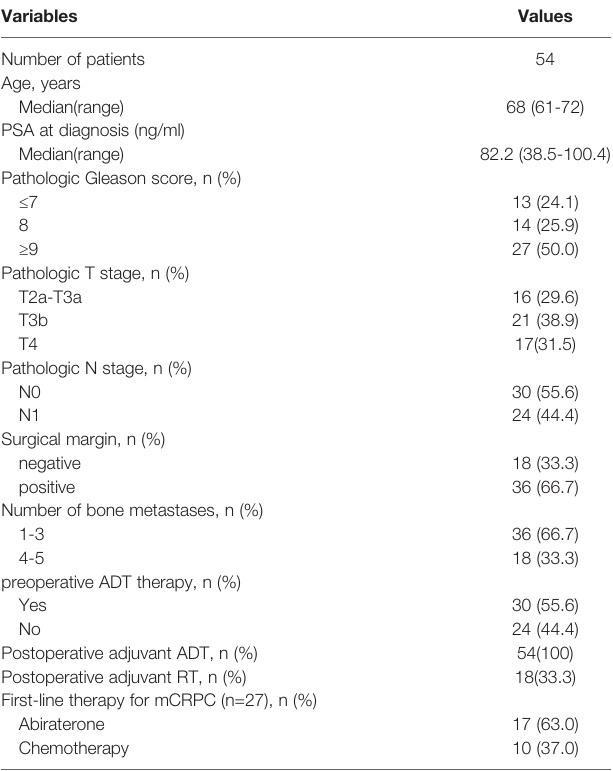
TABLE 1 | Patient